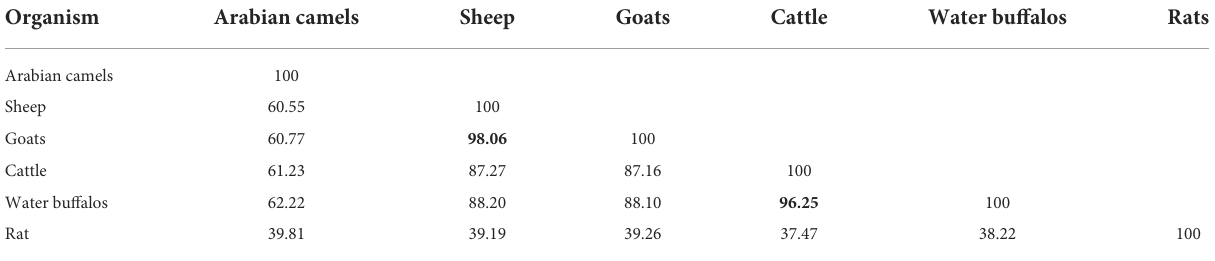
TABLE 2 Similarity values of the five domestic animals based on the combined caseins